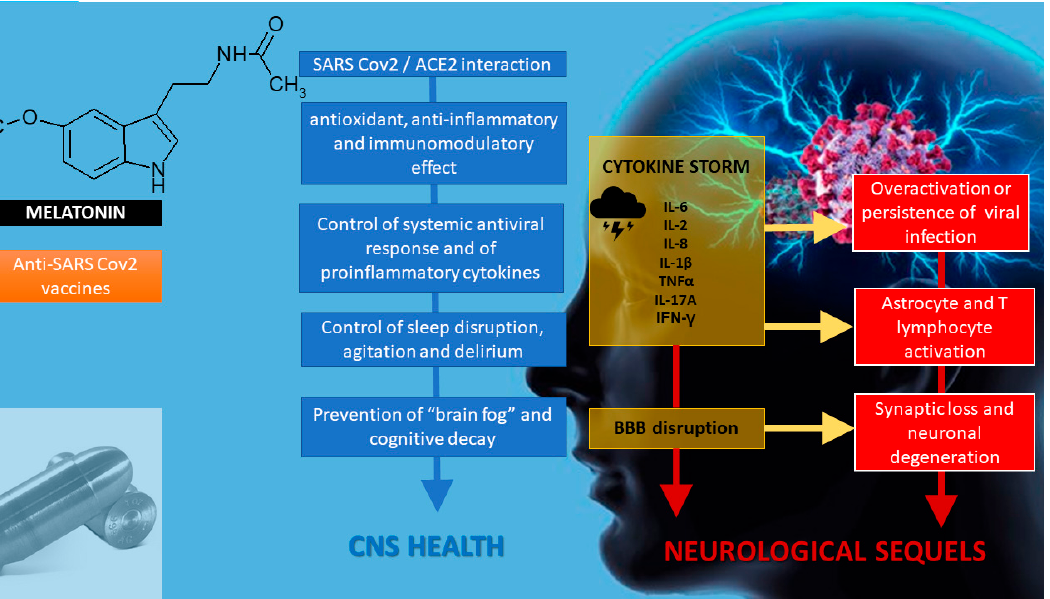
Figure 1. Melatonin as a potential “silver bullet” in the COVID 19 pandemic, as exemplified in the brain. Melatonin has possible antiviral activity by interfering with SARS-CoV-2 / angiotensin-converting enzyme 2 association. As an antioxidant, and anti-inflammatory and immunomodulatory compound, melatonin impairs the consequences of SARS-CoV-2 infection. Melatonin is an effective chronobiotic agent that reverse circadian disruption and delirium in intensive care unit patients. Melatonin may prevent neurological sequelae in COVID-19-infected patients like “brain fog” and cognitive decay. Melatonin can be an adjuvant for augmenting the efficacy of anti-SARS-CoV-2 vaccines. BBB: blood brain barrier.